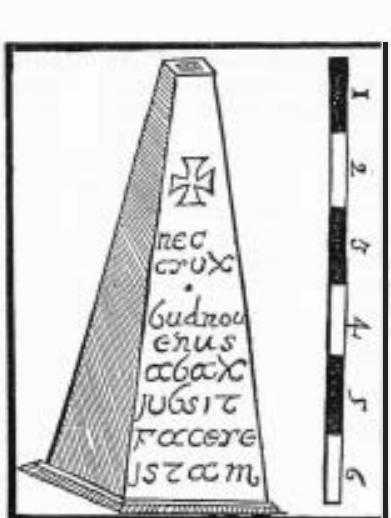
Figure 5 Lost Breton stone from Landun­ vtiz, as published in 1640 by Albert Le Grand in his work on the life of St Budoc, when its crosshead was already missing; it bore a ninth-or tenth-century inscription recording the erection of "this cross" by an unknown Abbot Budnouenus (scale in Ere­ ton feet, slightly longer than English feet).